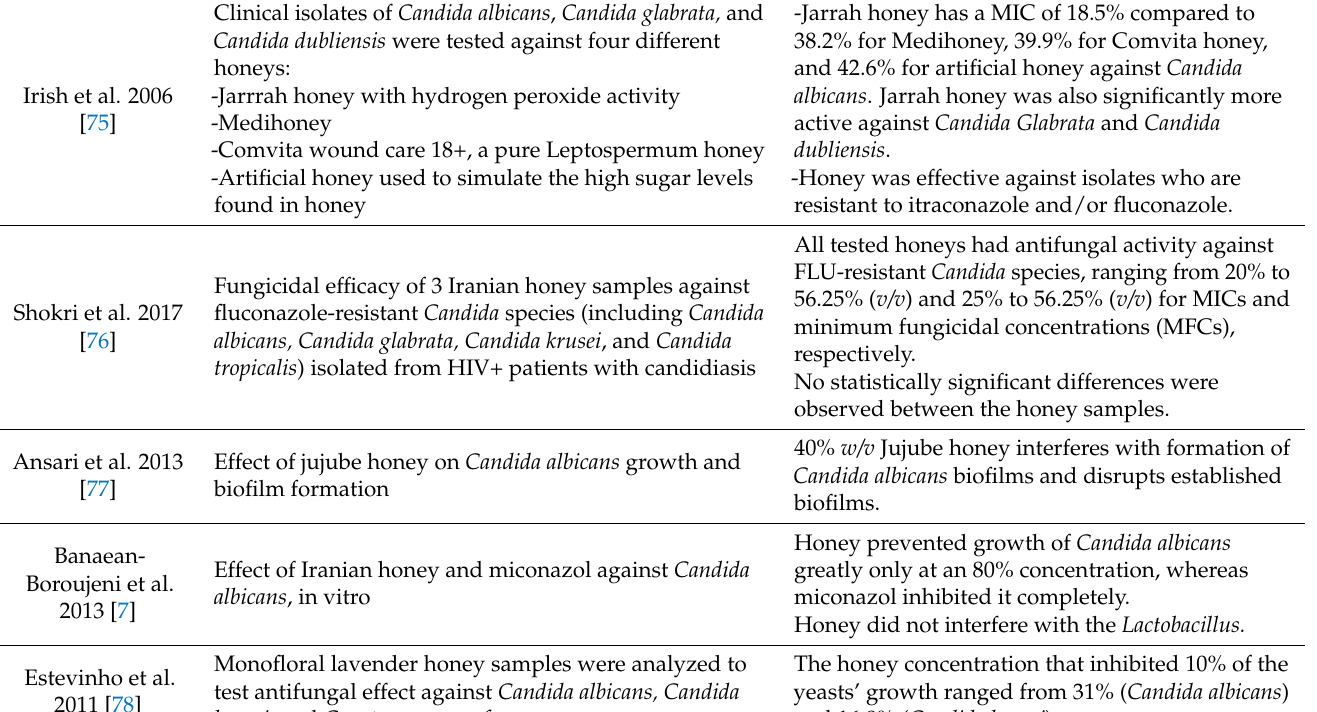
Table 2. Overview in vitro studies investigating the antimicrobial activity of MGH against Candida species. Selected